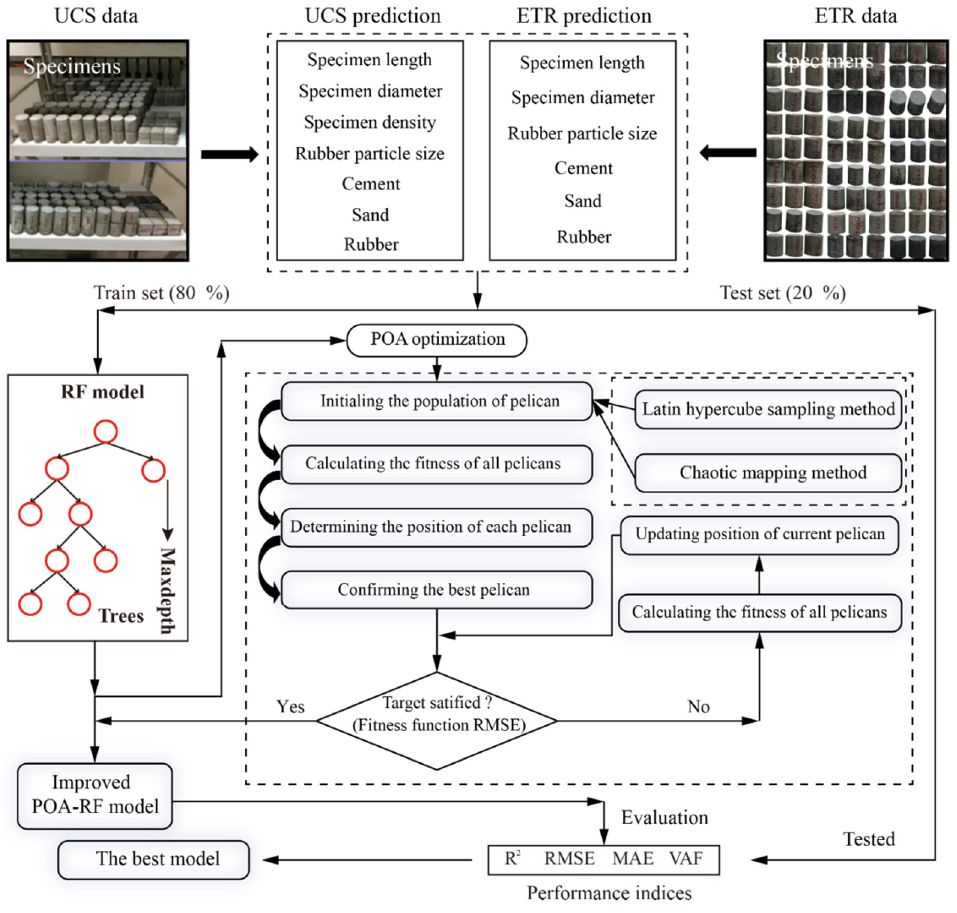
Figure 4. The framework of predicting the UCS and ETR of the novel concrete material.